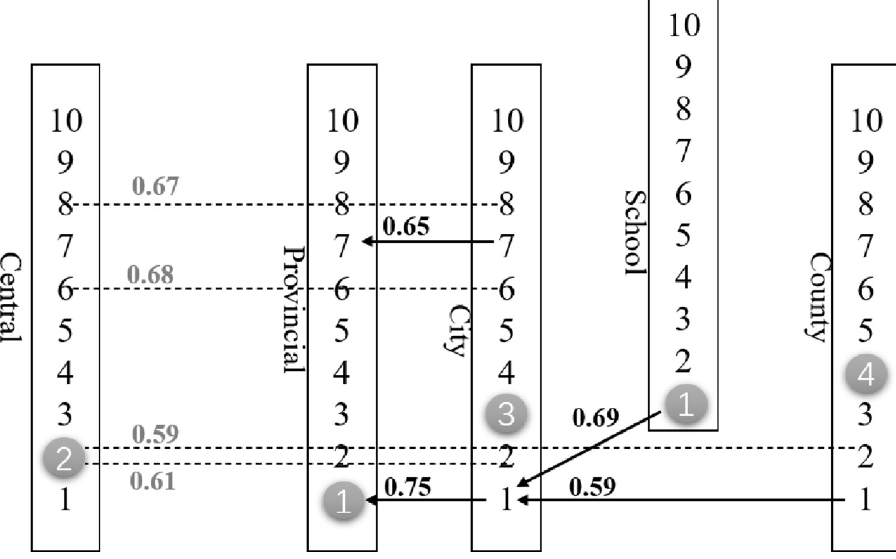
Fig 9. Graph of topic relevance between organizations. Note: The number in the figure represents the topic number. For example, the number 1 means Topic 01. The topics marked by white circles are the topics with the highest percentage of information published by the group at that level. Dashed lines indicate cross-level topic